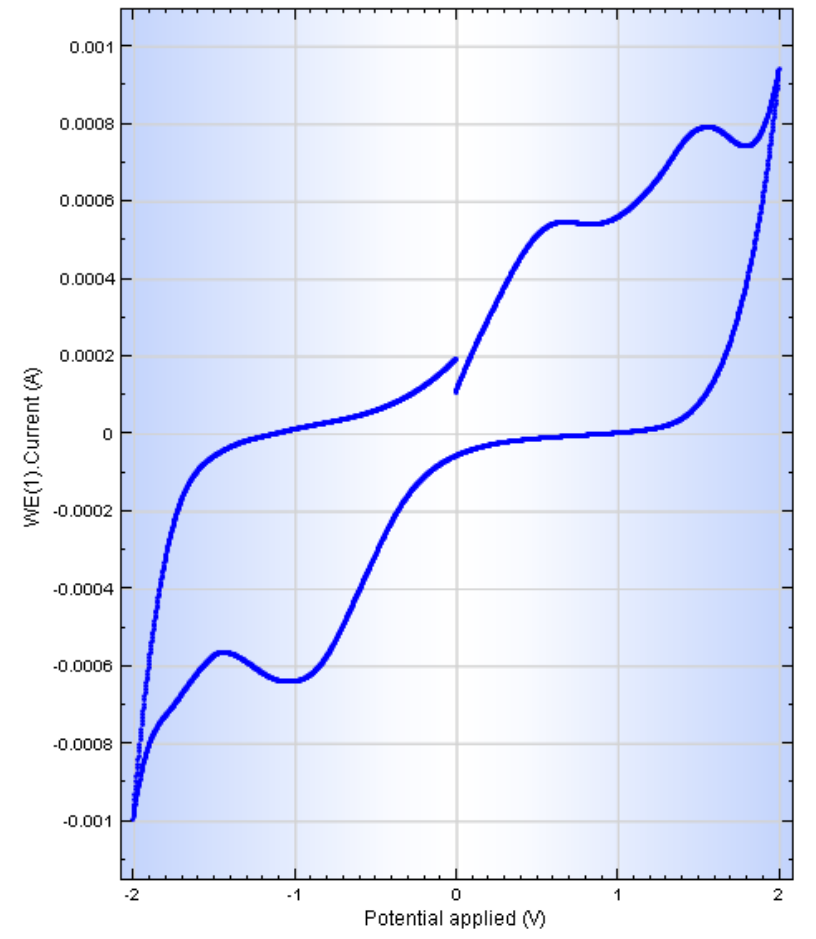
Figure 7. Voltammogram showing the electro-activity of the ECH formulation in a range between − 2 V to +2